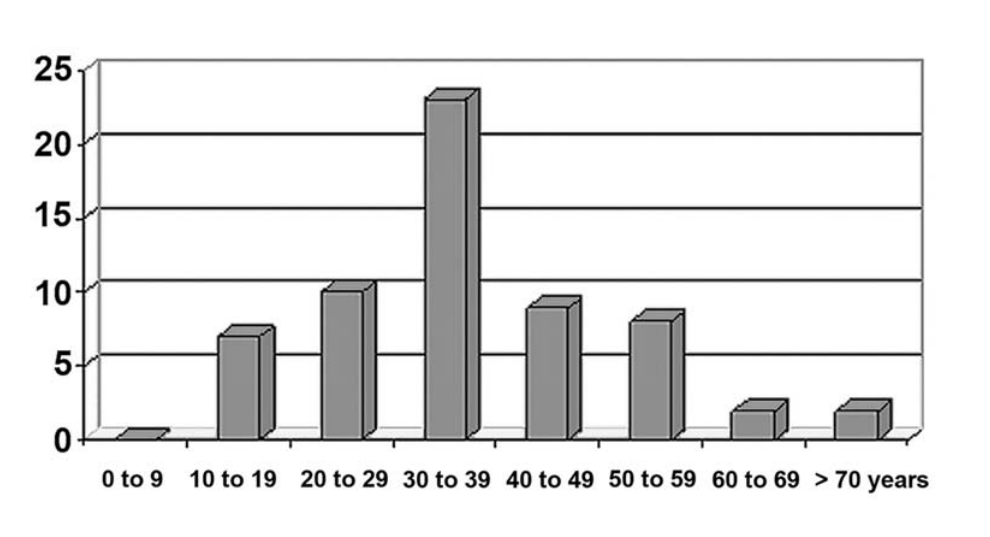
Figure 1 – Age distribution of the 80 patients with urogenital tuberculosis according to the